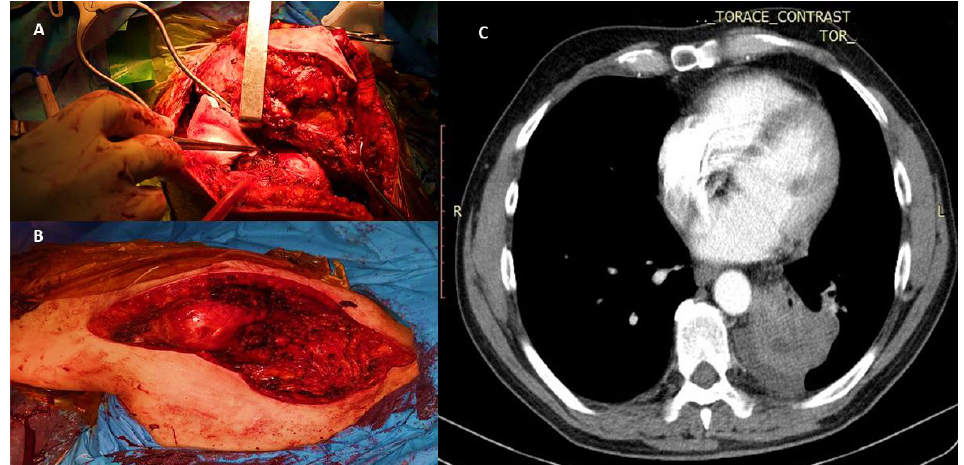
Figure 1. A 65-year-old man with a pulmonary neoplasm of the left-upper lobe confirmed by fibrobronchoscopy with right-scapular metastasis and invasion of adjacent soft tissues. Prior to radical pulmonary surgery, the patient underwent partial resection of the scapula (internal third), acromion, coracoid process, and lateral end of the clavicle (external third), together with the invaded soft tissue (subscapularis, suprascapularis, and infraspinatus muscles; humeral and clavicular insertion of the pectoralis major muscle; and insertion of the pectoralis minor and deltoid muscle). ( A ) Intra-operative view of scapular tumor mass (external third) invading the soft tissues and integument. ( B ) Post-excision tumoral aspect with soft tissue reconstruction that did not require prosthetic materials or skin graft. ( C ) CT scan of a left-upper lobe lung tumor diagnosed as lung cancer by fibrobronchoscopy.